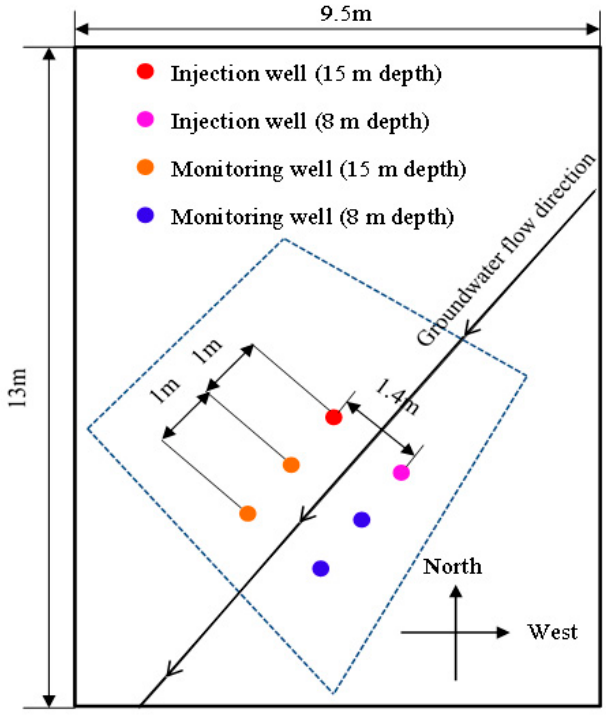
Figure 2. Distribution of injection wells and monitoring